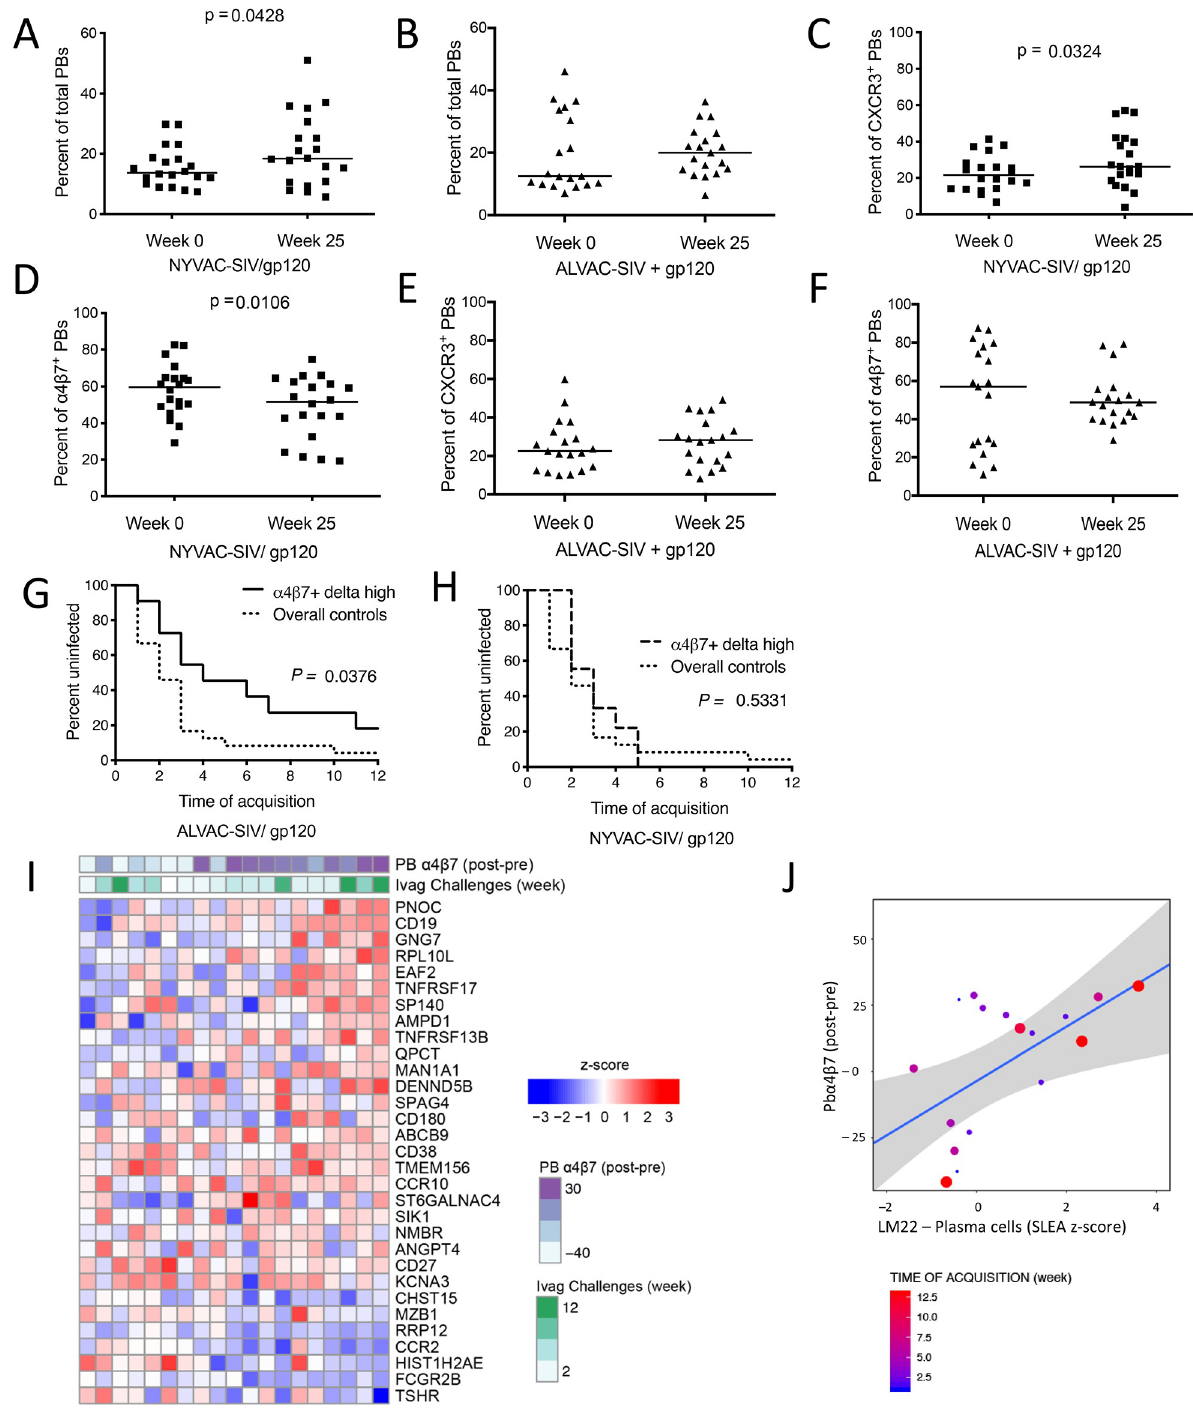
Fig 5. Vaccine-induced plasmablasts and risk of SIV mac251 acquisition. Comparison of the vaccine-induced variations in the frequency of plasmablasts (PBs) at week 0 and week 25. Total PBs in (A) NYVAC-SIV and (B) ALVAC-SIV groups. Percent of (C) CXCR3 + , and (D) α 4 β 7 + PBs in the NYVAC-SIV group. Percent of (E) CXCR3 + and (F) α 4 β 7 + PBs in the ALVAC-SIV group. (G–H) Survival curve showing significant protection in animals with above average increases in levels of α 4 β 7 + PBs (from baseline levels) and time to acquisition compared to controls in the (G) ALVAC-group and (H) in the NYVAC group. (I) GSEA analysis of the transcriptomic profile of the ALVAC-SIV/gp120 animals at week 25 revealed an enrichment of plasma cell markers among genes associated with lower risk of SIV acquisition. (J) The SLEA method was used to summarize plasma cell markers for each subject. The scatterplot shows average plasma cell markers as a function of the frequency of α 4 β 7 + PBs in ALVAC-SIV/